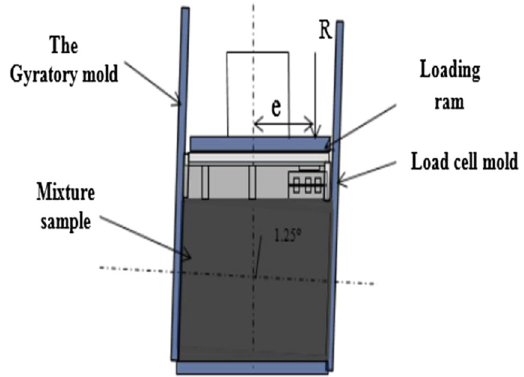
Figure 4: During gyration, measuring units are prepared in the SGC mold [ 15 ]